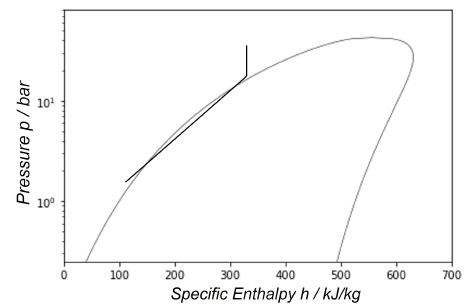
Figure 6. P-h diagram of the behaviour of the fluid inside the capillary tube when the adiabatic stretch length is shorter than the single-phase length, in the case where the fluid returns to subcooled liquid conditions once it enters the two-phase